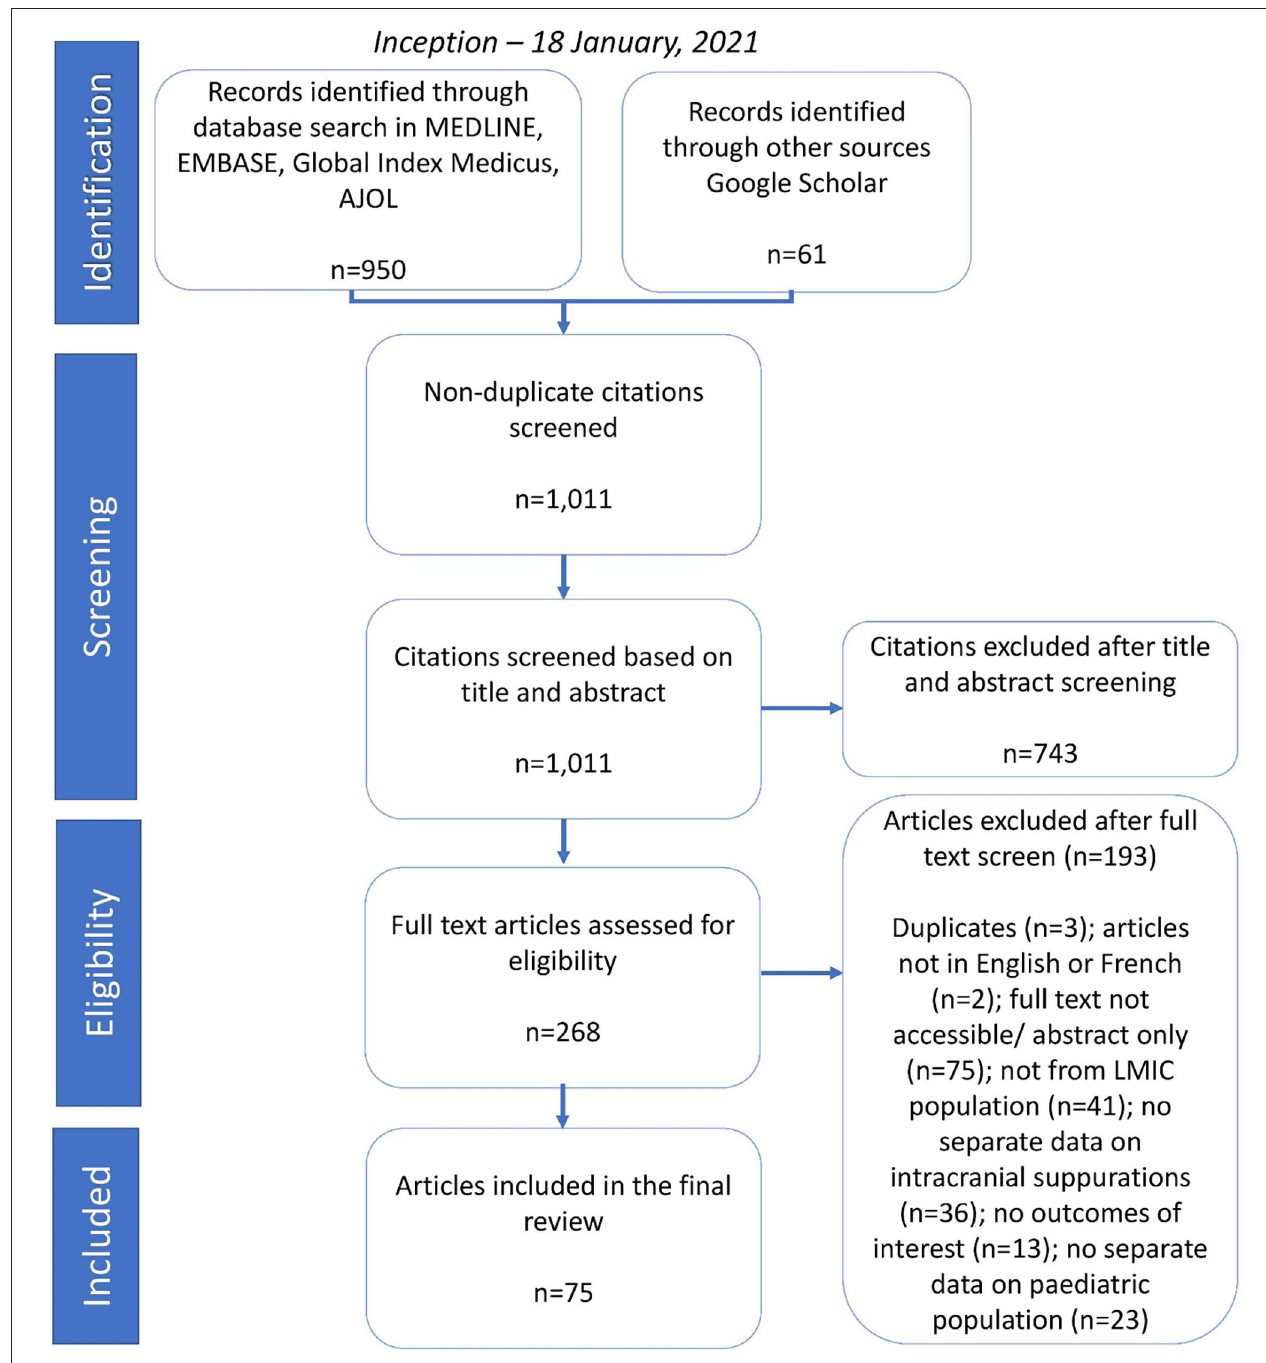
FIGURE 1 | PRISMA flow